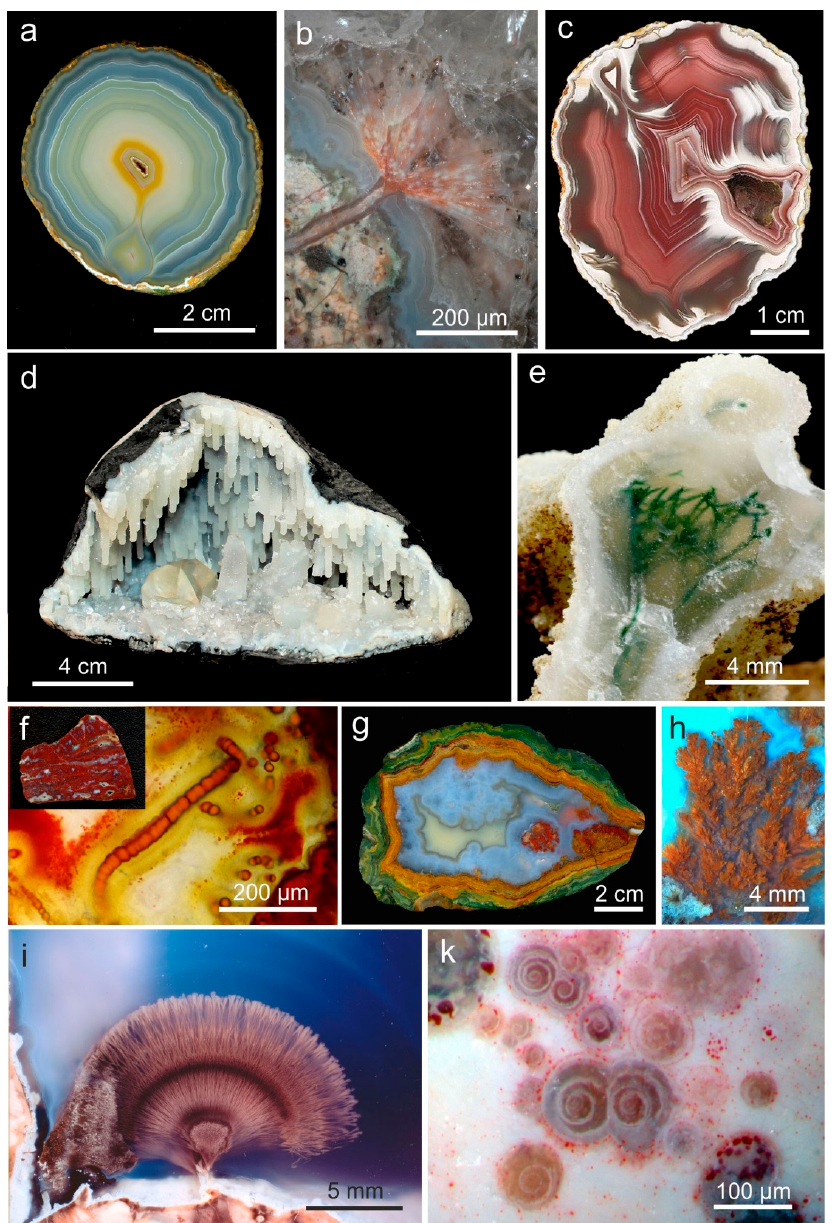
Figure 34. Structural peculiarities in agates: ( a ) agate from Moctezuma, Chihuahua (Mexico) showing a so called “infiltration channel” (“escape tube”); ( b ) micrograph of the marginal part of an agate from Zschaitz, Saxony (Germany) resembling the inflow channel of silica into the agate, which cross-cuts the outermost chalcedony layer; ( c ) agate from Agate Creek, Queensland (Australia) with multiple deformation features; ( d ) cavity from the Dekkan Trap basalt, India completely filled with quartz stalactites (SFF); ( e ) green filamentous structure in a moss agate from Jalna, India; ( f ) Fe ‐ rich agate of probably biogenic origin from the Mátra Mts., Hungary (inset) with filamentous pseudomorphs in the microcrystalline silica matrix; ( g ) agate from Kardzali (Bulgaria) with plume structures; ( h ) details of the reddish-brown plume structures in chalcedony matrix; ( i ) bundle-like structures resembling the shape of natural sheaf of wheat in an agate from the Darrell Friend Ranch near Ashwood, Oregon (USA) (sample courtesy G. Schiecke, photo A. Gabert); the unusual shape is probably caused by calcite traced in silica gel; ( k ) agate from Berschweiler near Idar-Oberstein (Germany) with inclusions of spiral forms probably developed from an amorphous silica precursor by self-organisation